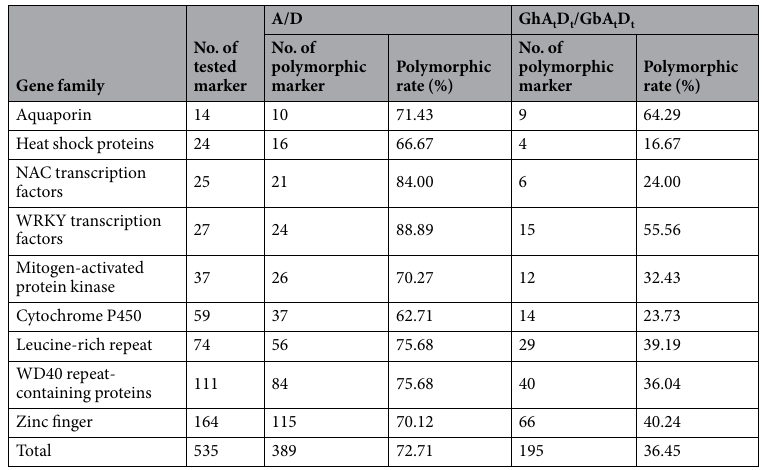
Table 3. ILP markers polymorphism between diploid A- and D-genome (A/D), or between tetraploid A t D t - genome (GhA species, G . barbadense cv. Hai7124 and G . hirsutum acc. TM-1.